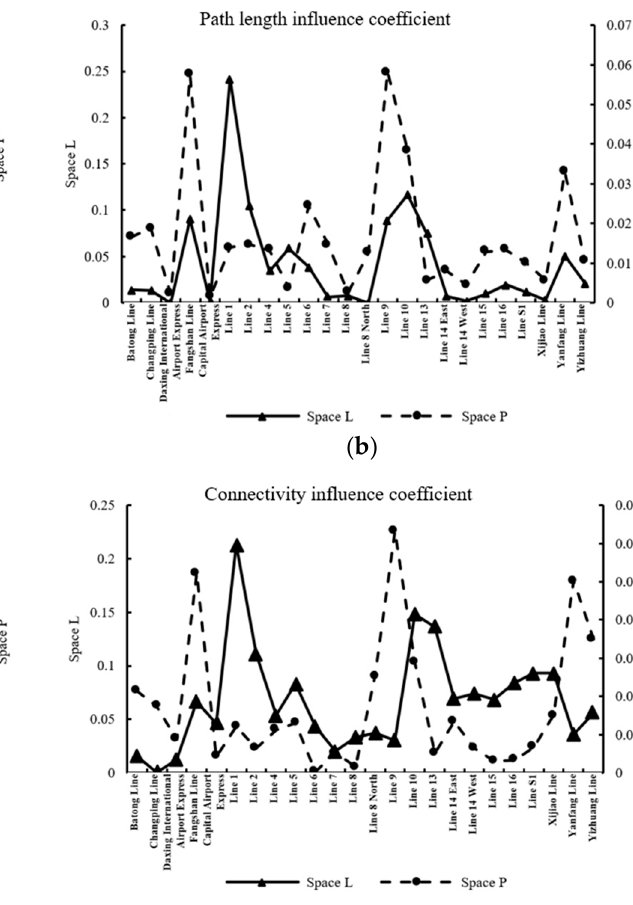
Table 11. Calculation results of interline impact index.